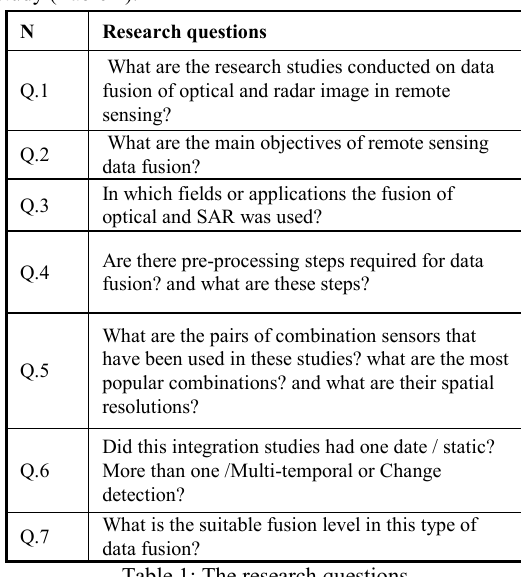
Table 1: The research questions